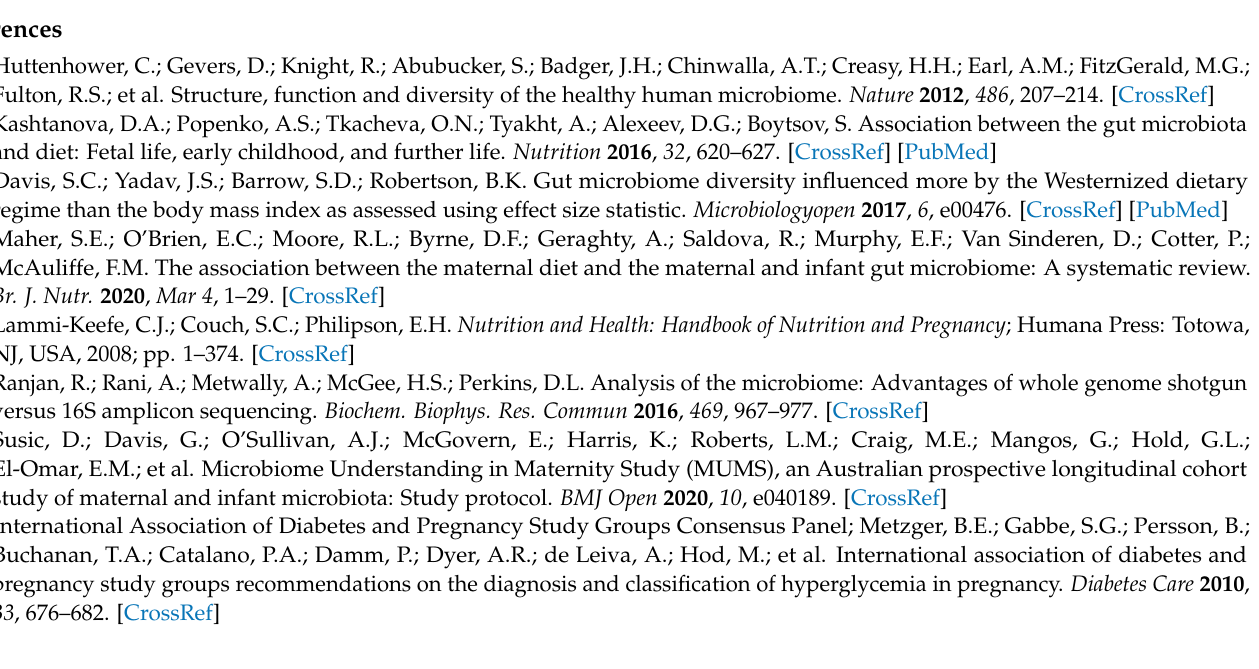
Figure S2: Beta diversity between Australian Recommended Food Score diet quality